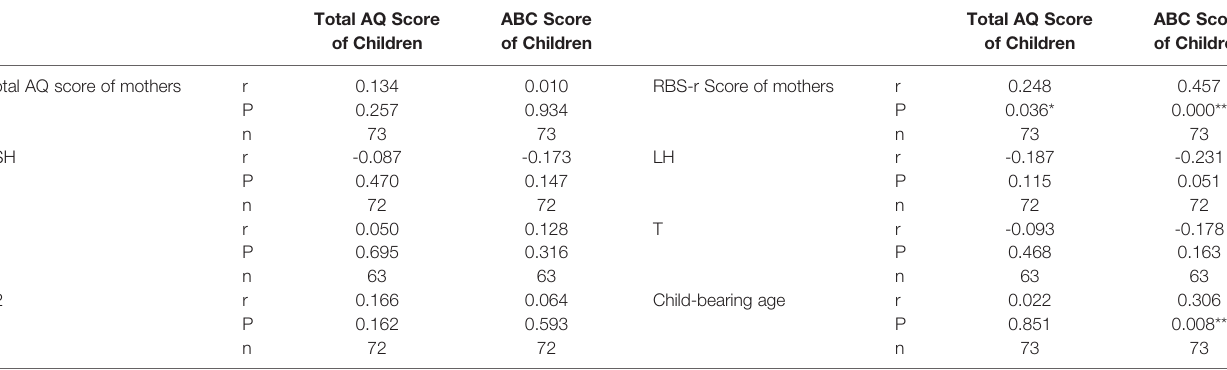
TABLE 5 | Correlation between total AQ score of children, ABC score of the sex hormone levels of children and mothers, the child-bearing age of mothers, the total AQ score of mothers, and the RBS-r score of mothers.